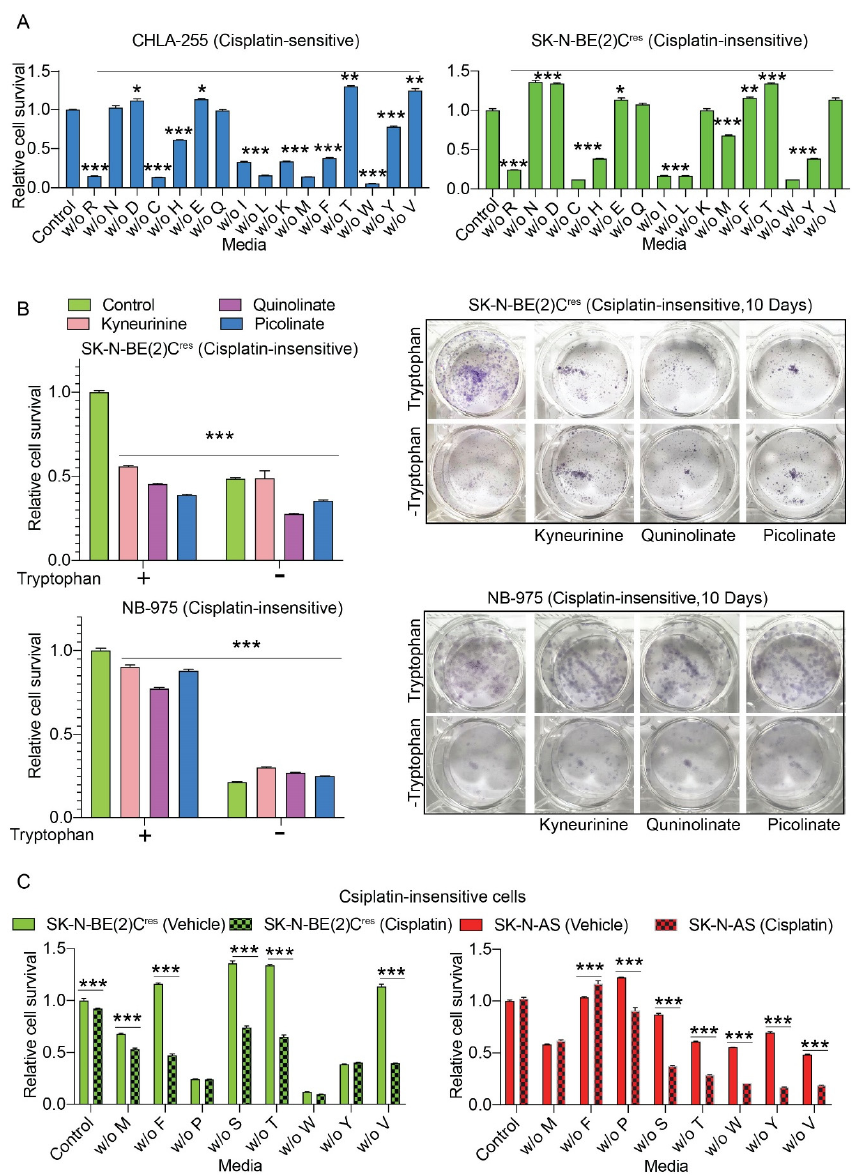
Figure 4. Amino acids regulate cisplatin-sensitivity. ( A ) Bar graphs showing relative change in cell survival of cisplatin-sensitive (CHLA-255) and cisplatin-insensitive (SK-N-AS) and cells cultured in control and amino-acid-deprived media for 72 h. Statistical comparisons were made between control and individual amino acid deprived conditions. Each bar represents mean ± SE of data obtained from three biological replicates. *, ** and *** indicate p < 0.05, p < 0.01 and p < 0.001, respectively, which were obtained through Student’s t -test. ( B ) Left panel: Relative change in survival of cells cultured for 72 h in media constituted either with or without Tryptophan and Tryptophan metabolites. Each bar represents mean ± SE of data obtained from three biological replicates. *** indicates p < 0.001 obtained through Student’s t -test by comparing survival in control media with the survival in modified media as shown in legend. Right panel: Images of cells cultured for 10 days according to conditions maintained in left panel of ( B ). ( C ) Bar graphs showing changes in cell survival of cisplatin-insensitive (SK-N-BE(2)C res and SK-N-AS) cells treated with cisplatin for 72 h in control and amino acid deprived media. Each bar in the graph represents mean ± SE of data obtained from either three biological replicates. *** indicate p < 0.001 obtained through One-way ANOVA and Sidak’s multiple comparisons test. Standard single letter amino acid codes were used to represent the amino acid labels in ( A , C